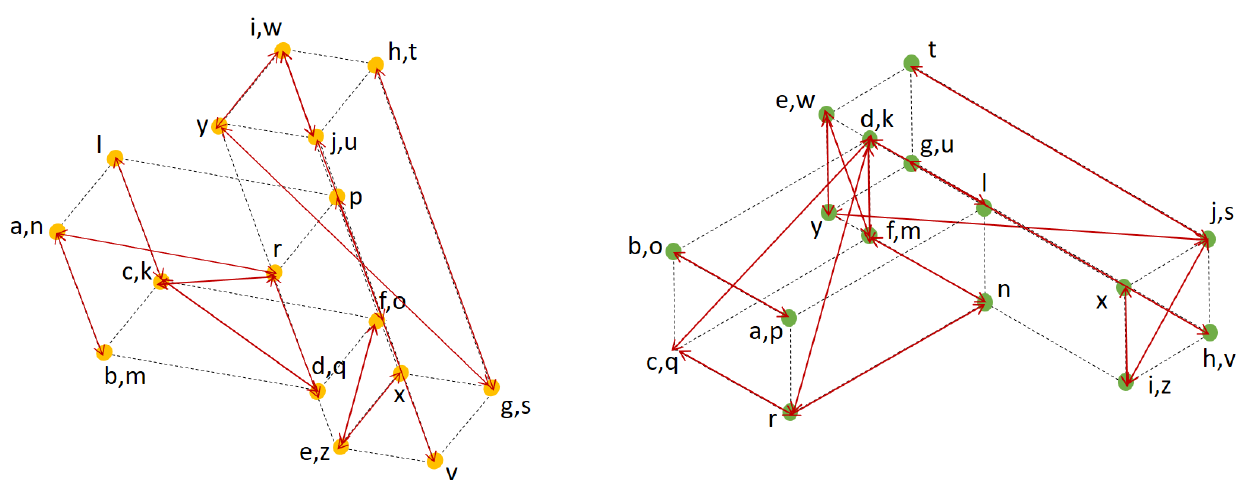
Figure 8. The identification of potential matching corner points from the as-built ( left ) and the as-planned model ( right ). The edges of the arrow with the same labels [a, b, c, . . . , y, z] in both models represent the potential matching points .